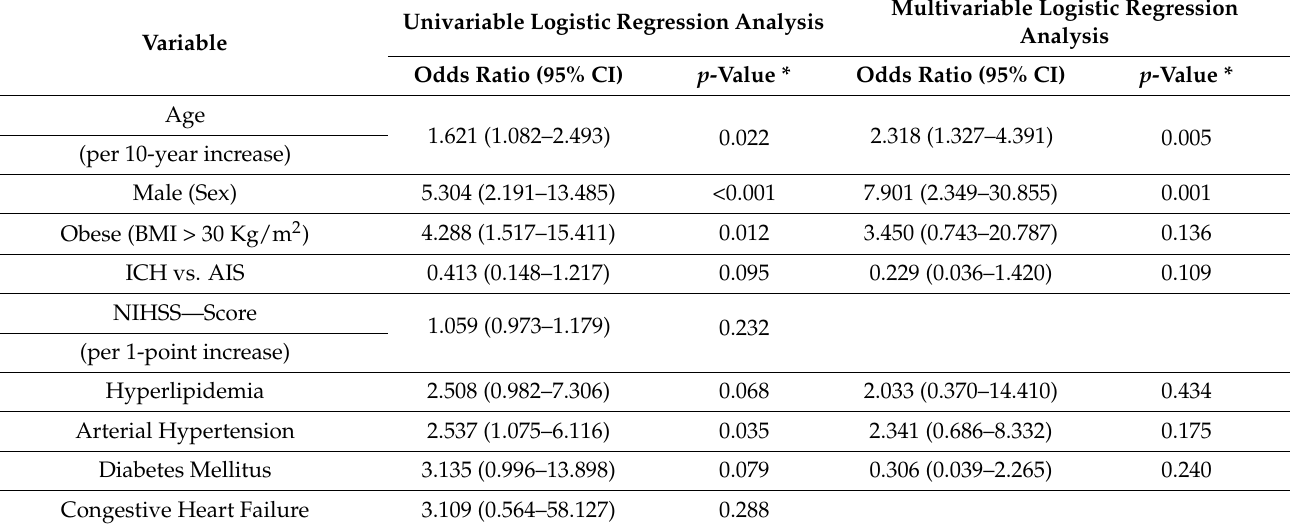
Table 2. Univariable and multivariable logistic regression analyses depicting the associations of baseline characteristics with the likelihood of detecting sleep-disordered breathing